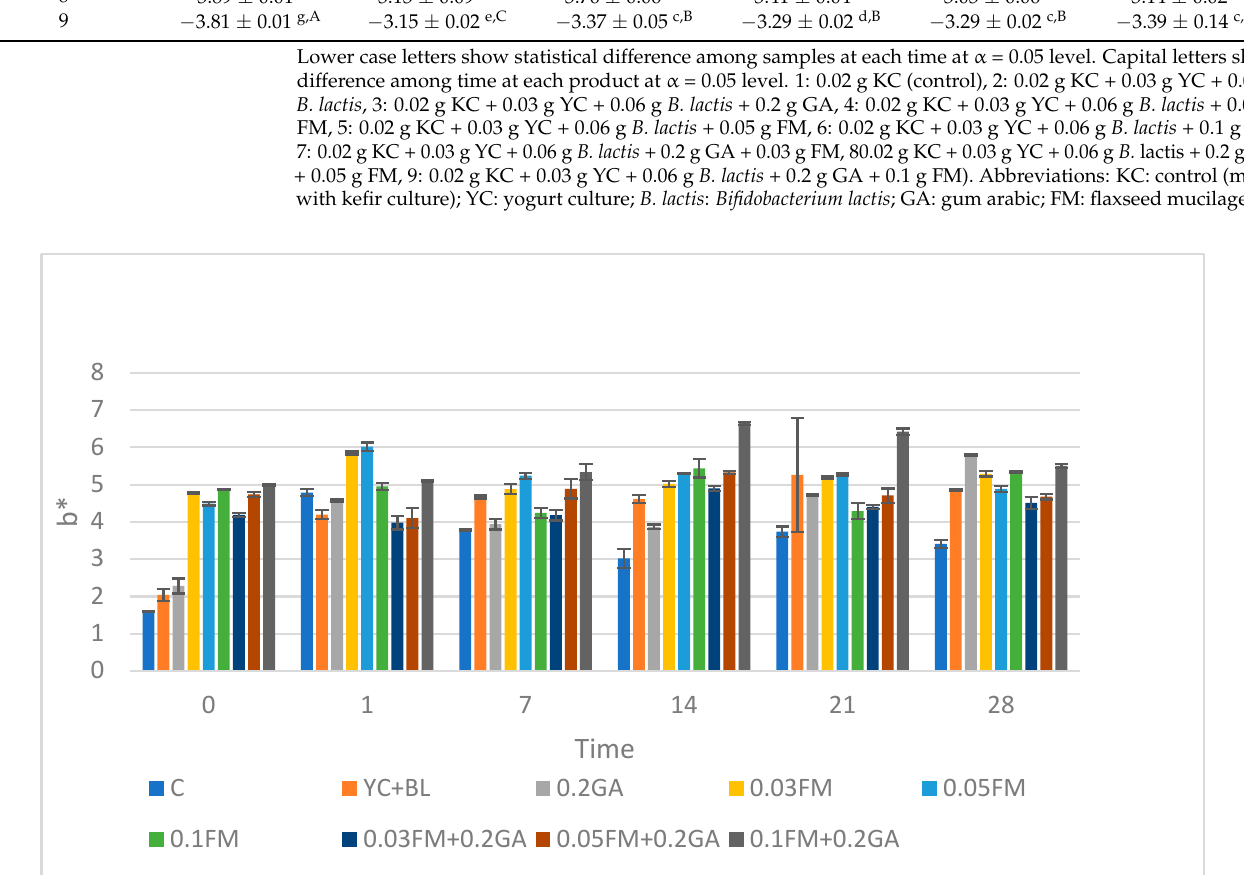
Figure 4. Effect of addition of FM, GA and yogurt culture and B. lactis at different concentration on color b* value in kefir samples during storage time. Abbreviations: C, control; YC, yogurt culture; B.L, B. lactis ; GA, gum arabic; FM, flaxseed mucilage.